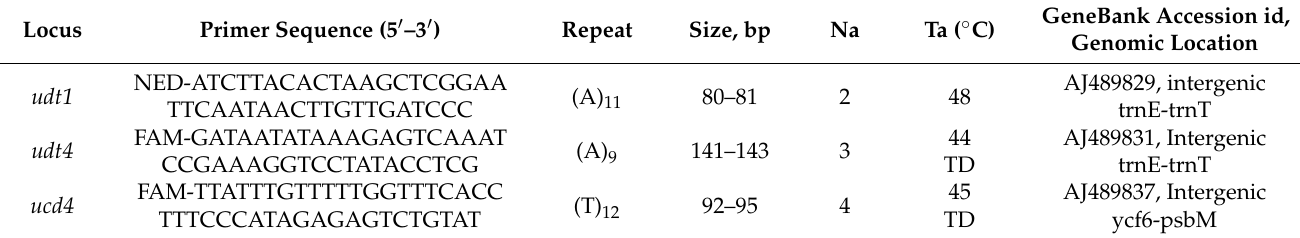
Table 2. Description of the cpSSR loci used in our study.